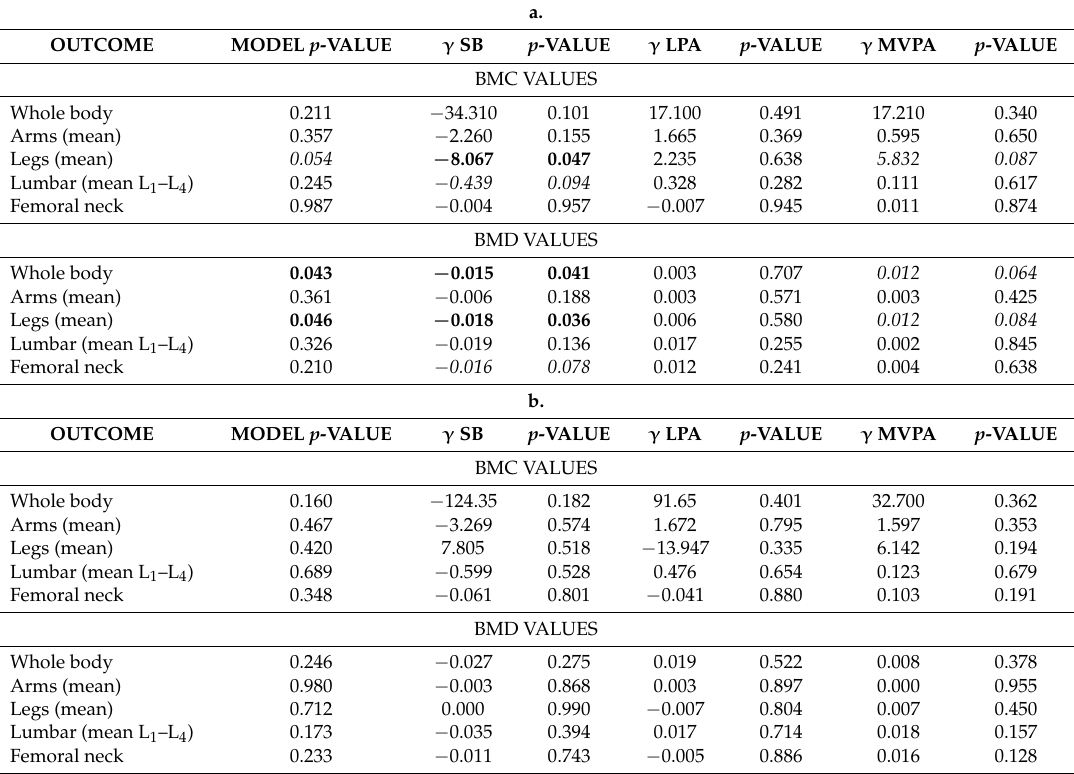
Table 3. Compositional behavior model for bone mass variables for the proportion of the waking hours of the day spent in SB, LPA and MVPA for robust men ( a ) and pre-frail men subgroup ( b ). a.